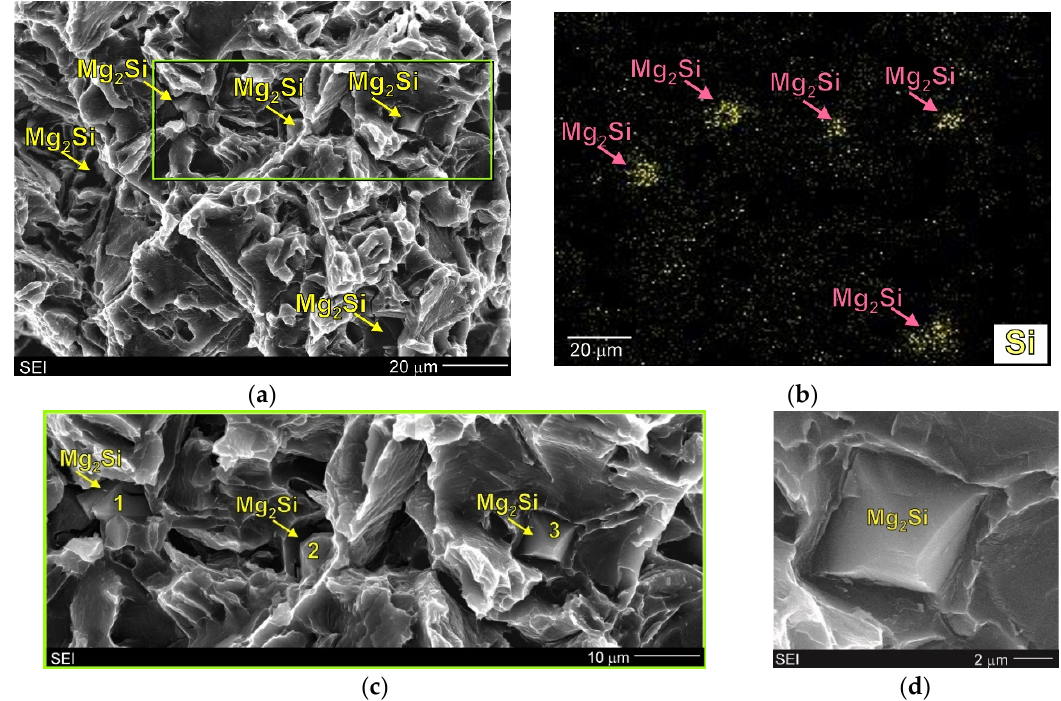
Figure 11. SEM micrographs of Mg/Mg 2 Si–HR composite fracture surfaces (after uniaxial tensile test) ( a ) with adequate silicon surface distribution (EDX) ( b ), higher magnification of area in green frame ( c ) and higher magnification of the Mg 2 Si phase designated as 3 in ( c ) micrograph ( d ).